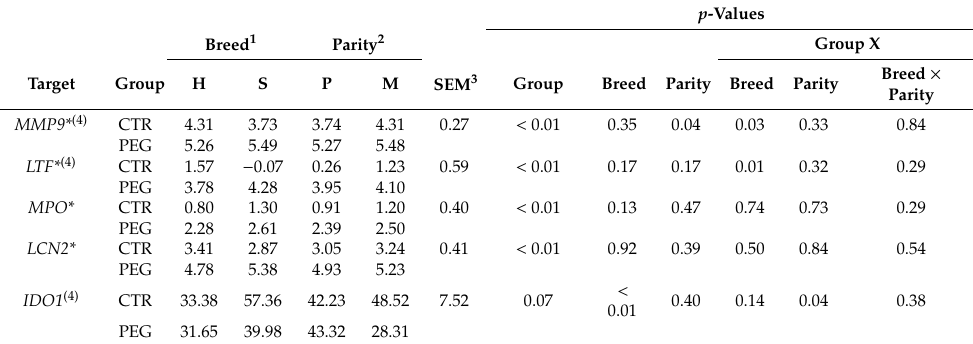
Table 3. LSM of arbitrary mRNA abundance for genes related to antimicrobial strategies in whole blood leukocytes evaluated 3 days after calving from Simmental and Holstein cows treated with pegbovigrastim (PEG) or with saline (CTR) at approximately Day 7 relative to calving and within 24 h the day of calving.